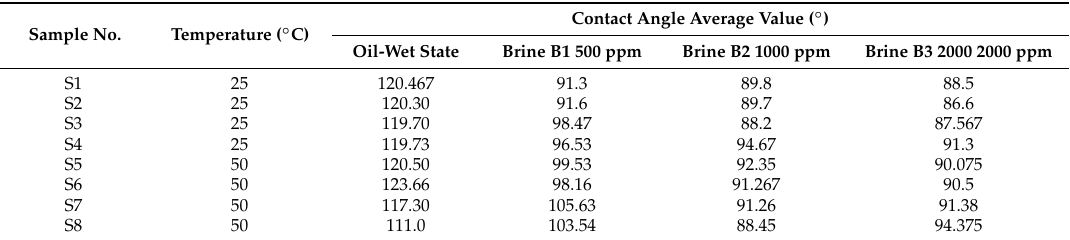
Table 6. Contact angle values of eight samples before and after injection with brines B1, B2 and B3. Sample No.